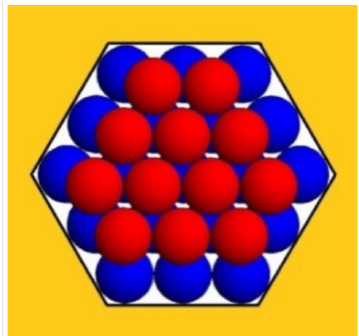
Figure 2. The two closest-packed layers of monomolecular thickness formed in a hexagonal pore orifice are shown in top view: the completely stable crystal nucleus with edge length L = 3 (layer A) is shown by blue balls and a second (ditrigonal) layer B (red balls) is deposited on